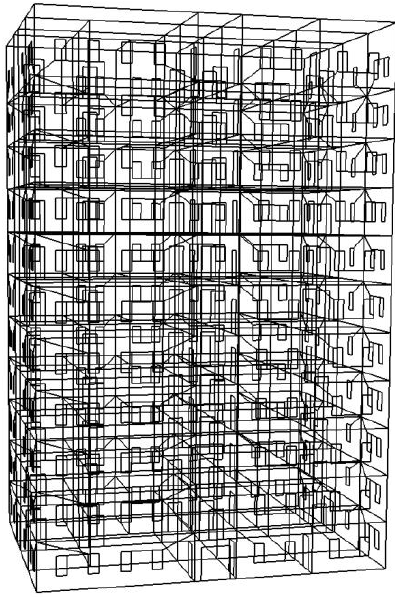
Figure 4. Mock dataset: a building model.